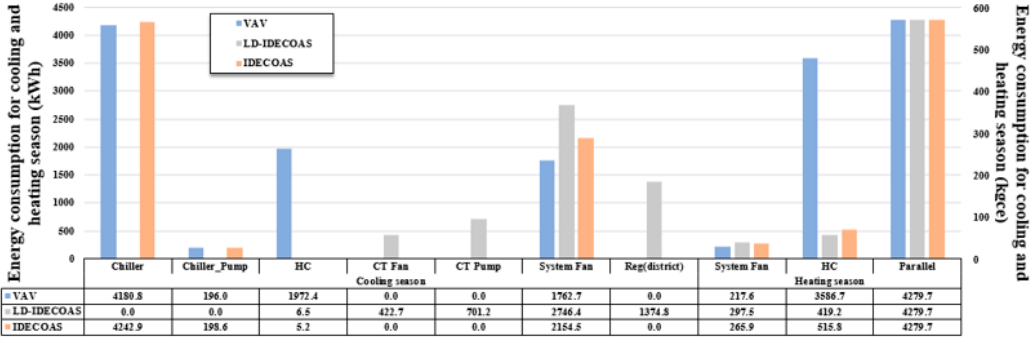
Figure 13. The seasonal energy consumption comparison in Beijing.